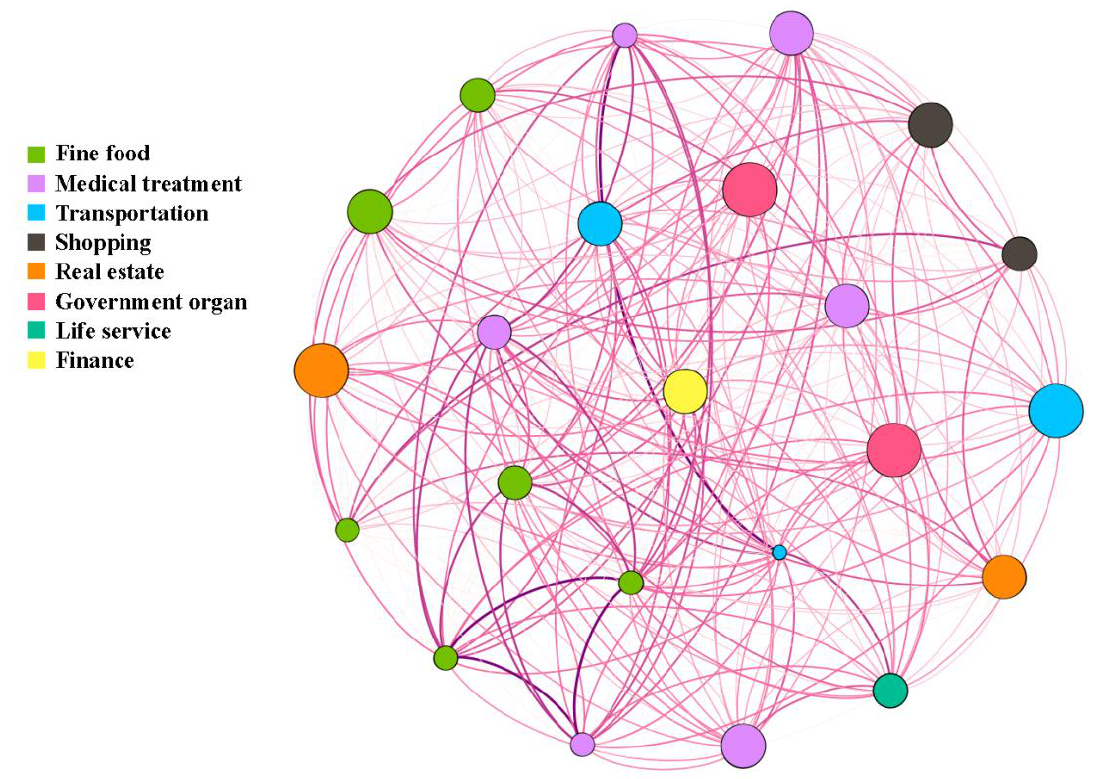
Figure 6. Complex network of urban functions under the lockdown of COVID-19 in Shenzhen. In Figures 5 and 6 the larger the node is, the more the number of the dominant urban functions calculating in districts is; and the wider the edge is, the stronger the interdependency between the urban functions is. From Figure 5, small nodes represent rare urban functions, and the large nodes mean common urban functions. There are fewer small nodes and more large nodes, which shows that more common urban functions are dominant before the lockdown of COVID-19. The interdependencies between relatively small nodes, such as airport and auto inspection, etc., show strong positive. The interdependencies between larger nodes are weak, and these urban functions cannot easily be affected by the change of other functions. From Figure 6, there are fewer nodes under the lockdown of COVID-19 than those before it, because most urban functions are out of operation and only the necessary urban functions are remained due to the lockdown of COVID-19. The larger nodes are relatively more than the smaller ones, and similarly, the interdependencies show stronger between the small nodes than those between the larger ones. It shows that more common urban functions are dominant, and the interdependencies between the common urban functions are weak in Shenzhen under the lockdown of COVID-19. The degree of the urban functions with positive and negative interdependencies before and under the lockdown of COVID-19 is computed by using Gephi, and the results are shown in Tables 3 and 4. In these tables, ‘Before’ represents before the lockdown of COVID-19, ‘Under’ represents under the lockdown of COVID-19. Degree means the total number of edges connected to a